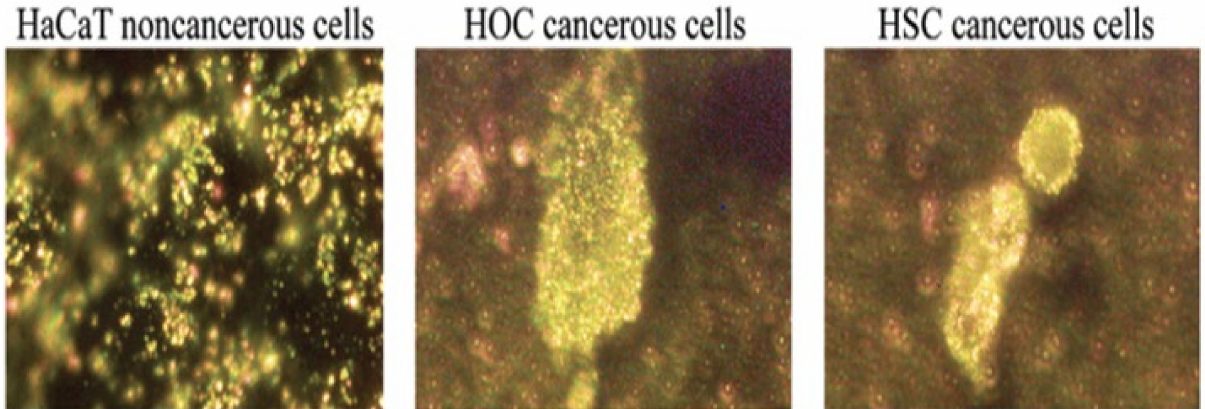
Figure 60. SPR light scattering images to distinguish between normal cells (left panel, HaCaT) and cancerous cells (middle and right panel, HOC and HSC) after incubation with anti-EGFR conjugated Au NPs. The anti-EGFR conjugated Au NPs bind specifically to the surface of cancer cells resulting in a sharper SPR band with a red-shifted maxima. Reproduced with permission from Nano Letter [500]. Copyright 2005, American Chemical